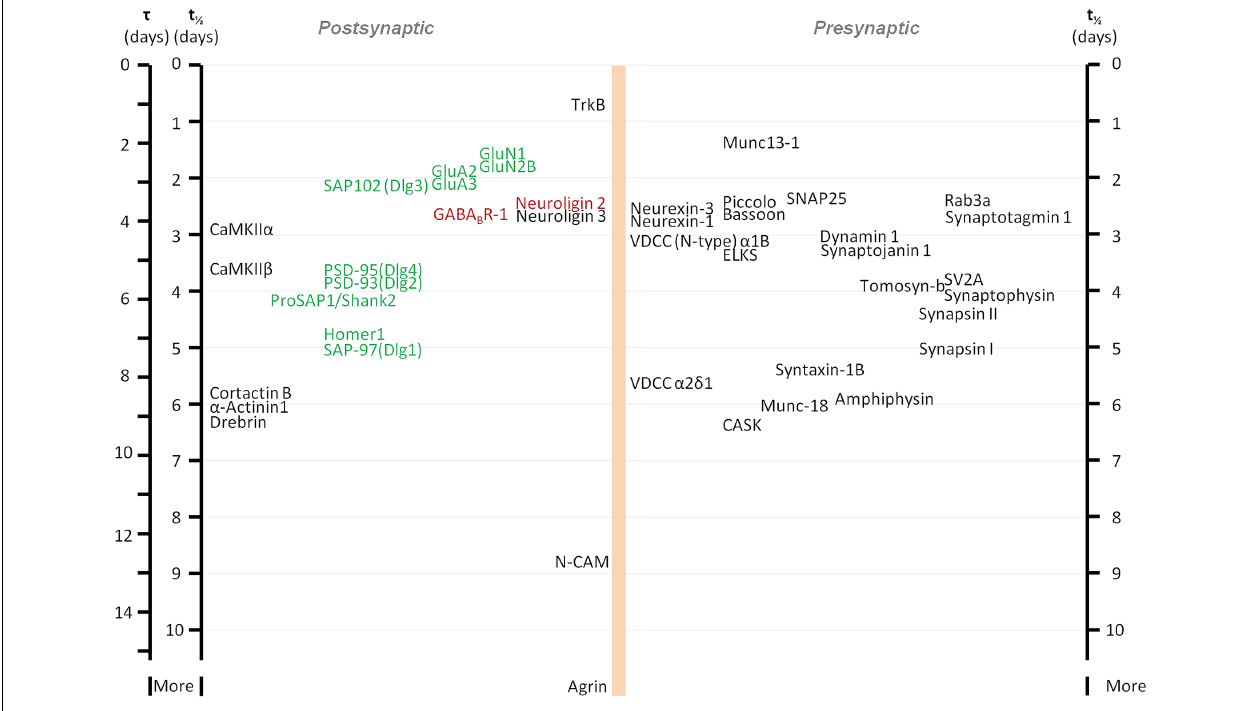
FIGURE 1 | Metabolic half-life estimates for several well characterized synaptic proteins. Proteins associated primarily with glutamatergic and GABAergic synapses are shown in green and red, respectively. Note that some related proteins have rather similar half-lives (some proteins with very similar half-lives were separated slightly to increase readability). Adapted from Cohen etal.